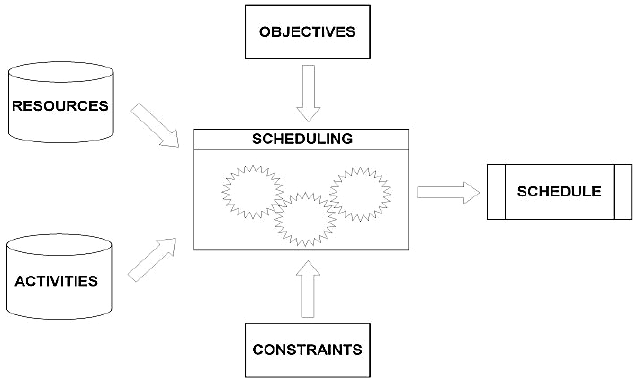
Fig. 1. The schema of a general scheduling